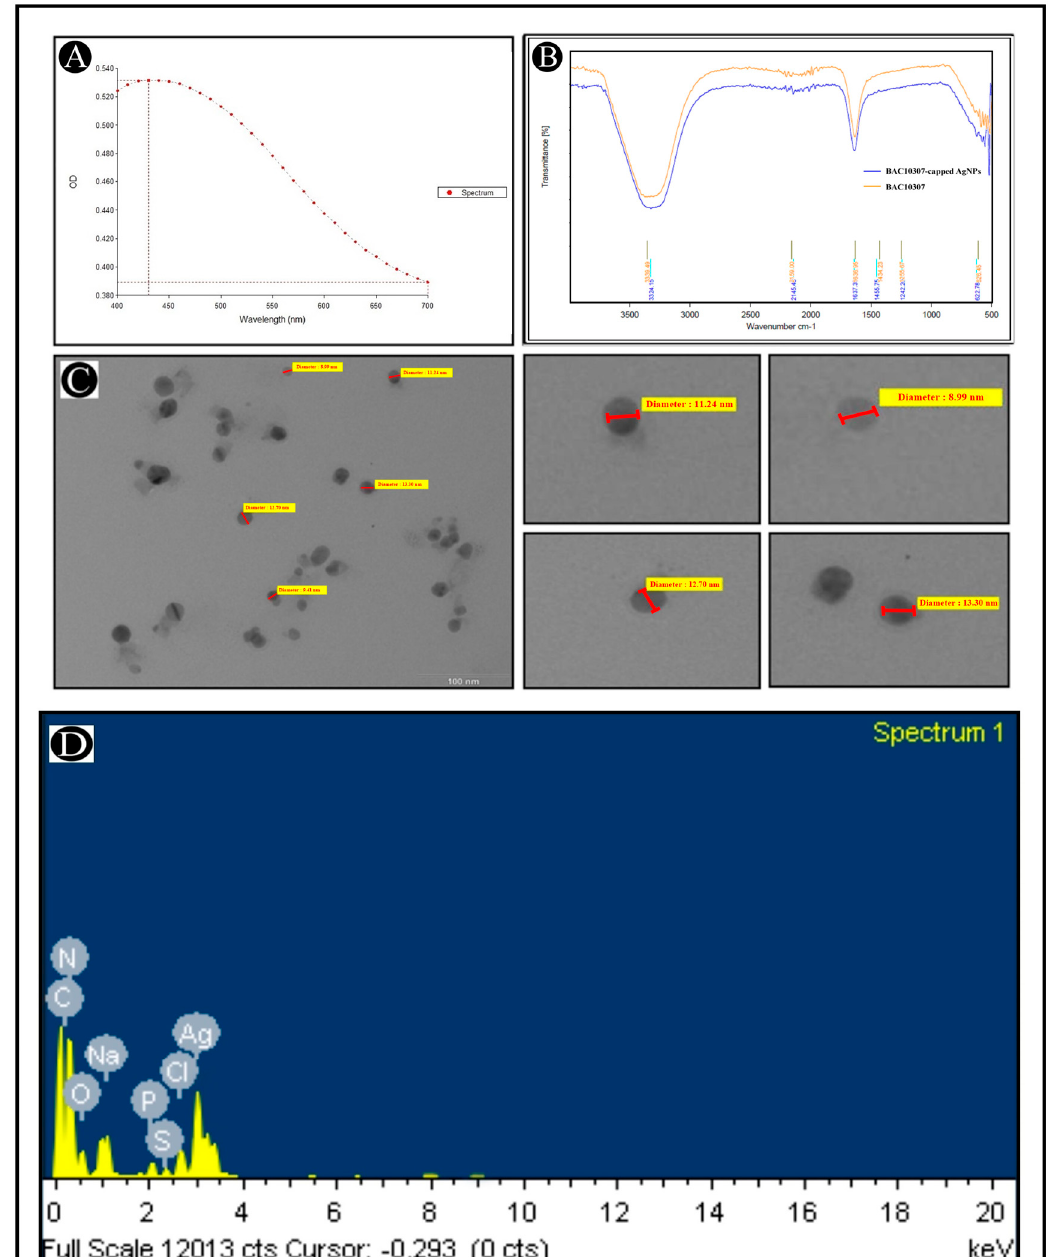
Figure 4. Characterization of Bac10307-AgNPs. ( A ). UV-visible absorption spectra of synthesized Bac10307-AgNPs. ( B ). FT-IR pattern of Bac10307 and Bac10307-AgNPs. ( C ). Morphological analysis of synthesized Bac10307-AgNPs with variable diameter using TEM analysis. ( D ). EDX